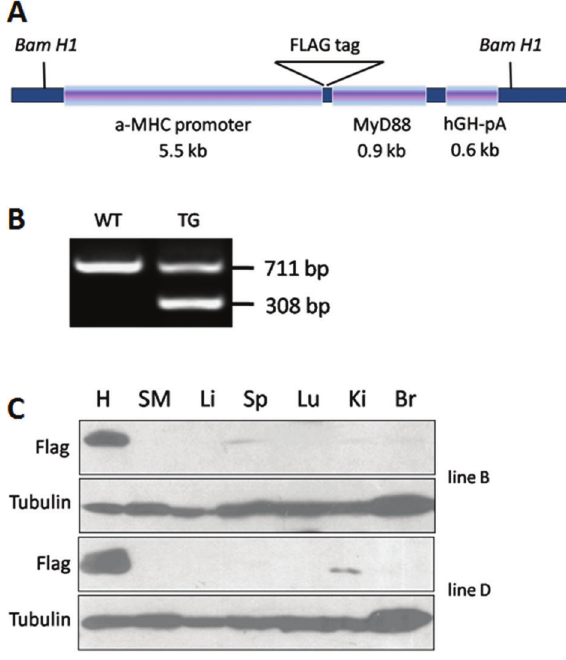
Figure 2. Histological analysis of MyD88 transgenic (TG) hearts. A , Gross appearance of the isolated wild-type (WT) and TG heart. B , Microscopic view of H&E-stained left ventricular sections from MyD88 TG and WT mice. Scale bar: 2 m